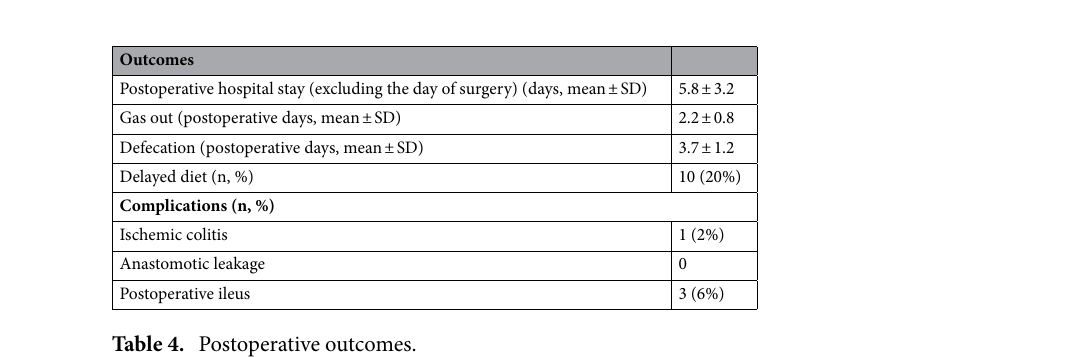
Table 4. Postoperative